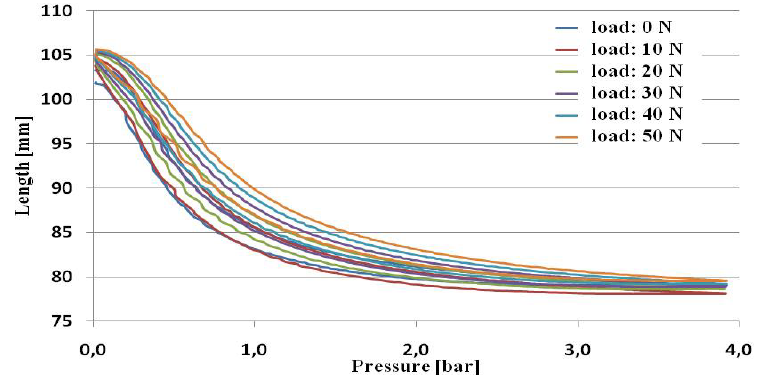
Figure 12. Length-pressure tests on a para-aramid muscle.